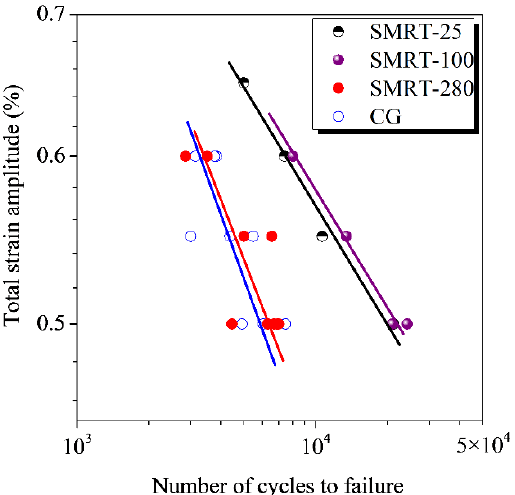
Figure 6. Dependences of fatigue life on total strain amplitude of SMRT samples prepared at different temperatures, in comparison with that of the CG sample.